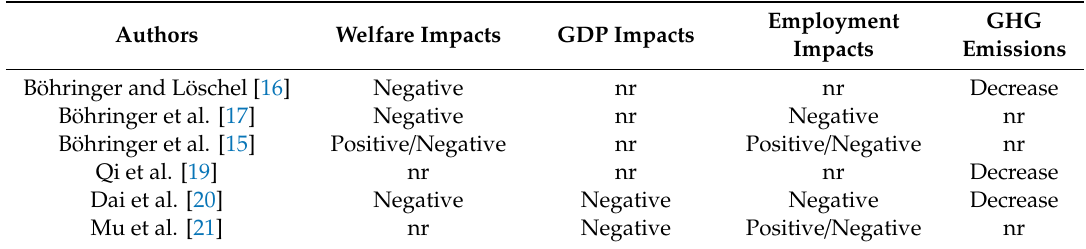
Table 1. Impacts on key outcomes of renewable expansion